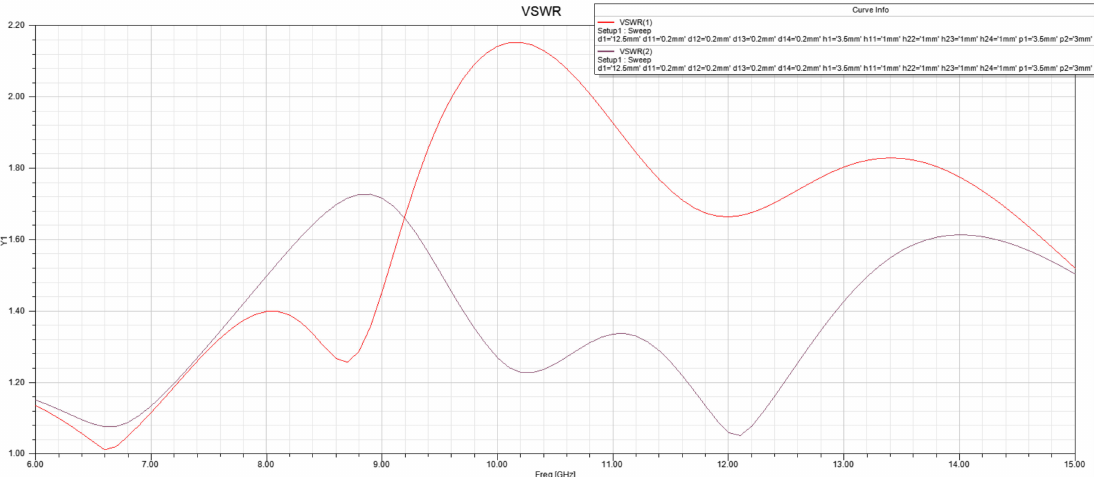
Figure 18. Input and output VSWR of the designed